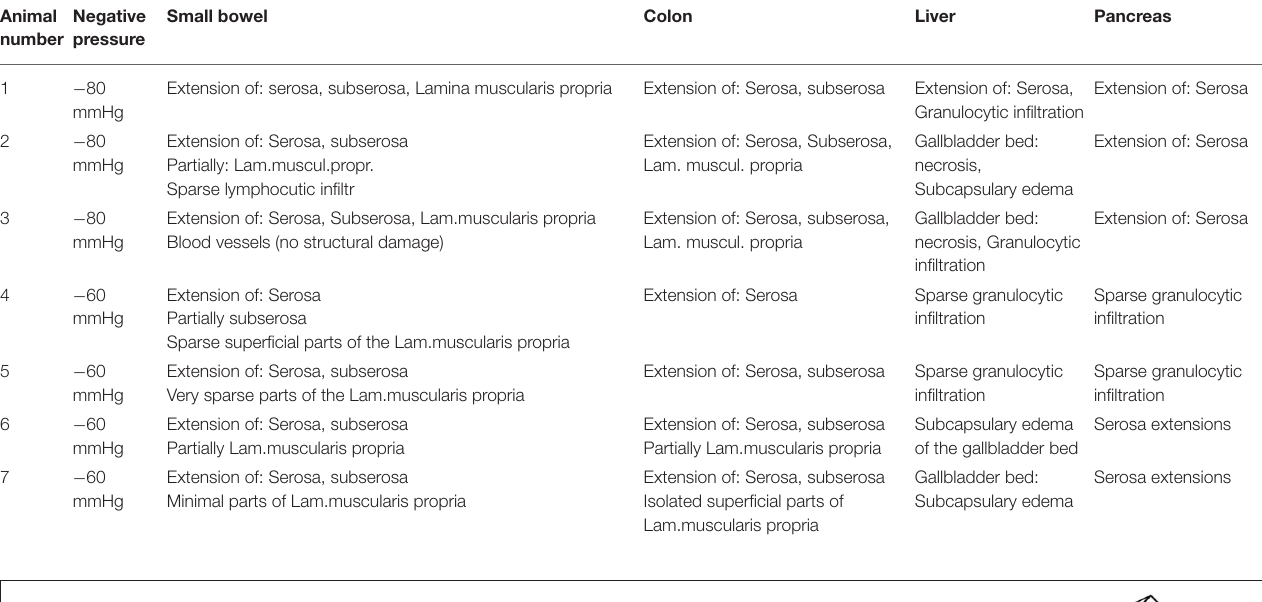
TABLE 1 | Histological findings for small bowel, colon, liver, and pancreas of animals 1–7, indicating corresponding negative pressure. Animal Negative Small bowel Colon number pressure